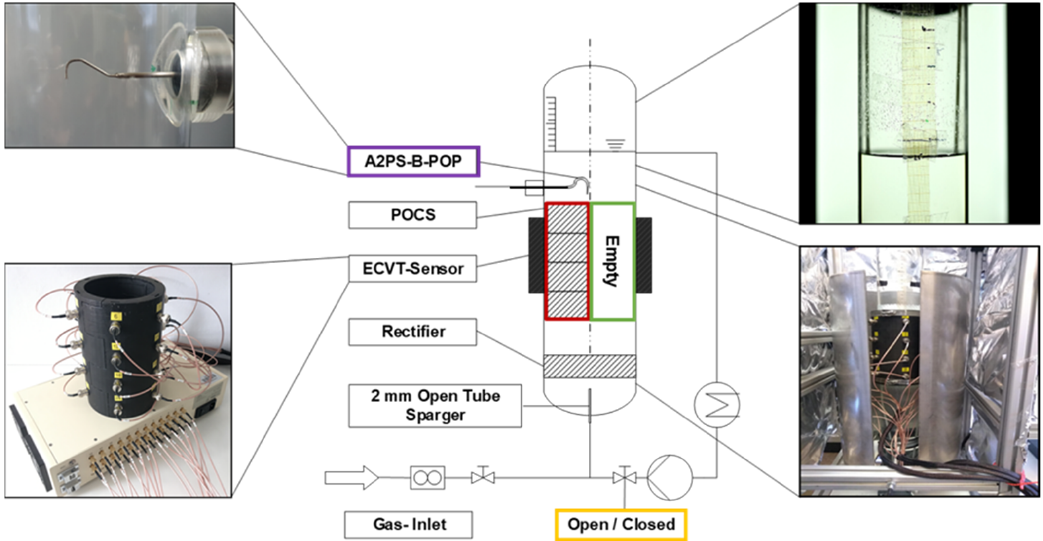
Figure 2. Experimental setup for the four different cases (liquid flow mode: stagnant or co-currently liquid flow; with/without packing) including A2PS-B-POP optical needle probe.